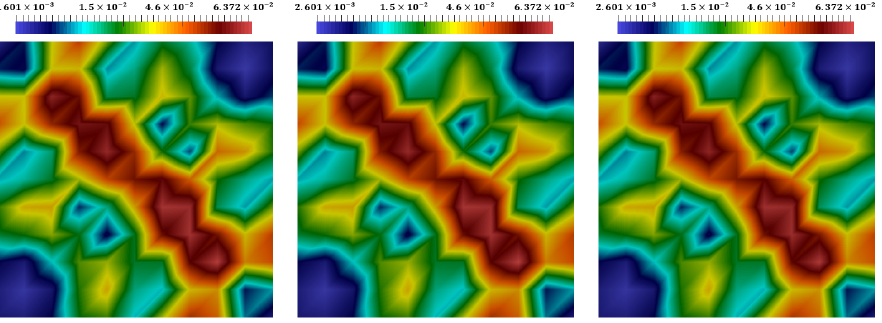
Figure 10. Distributions of the stress at the final time. The coupled explicit–implicit solution, the split explicit–implicit solution, and the proposed approach’s solution (from left to right ).